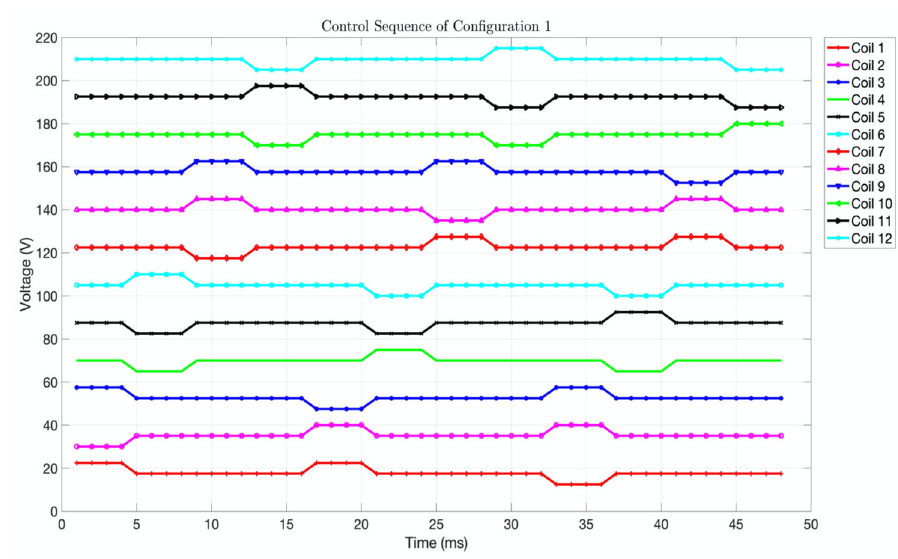
Figure 6. Switching signals of the twelve magnetic poles for CT1.